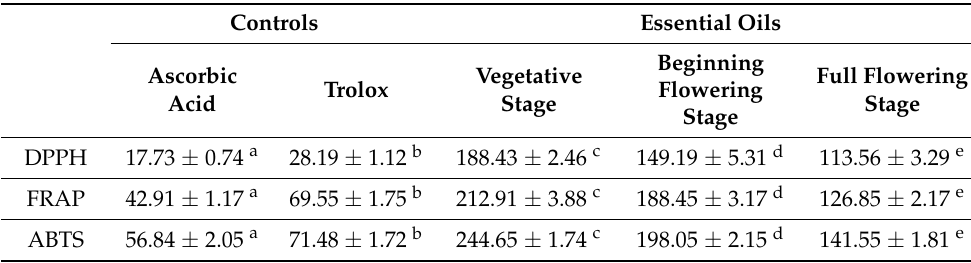
Table 3. The antioxidant activity of SOEO (IC 50 in µ g/mL) at three developmental stages. The results are presented as means ± SD (standard deviations) for triplicate assays. Controls Essential Oils Beginning Ascorbic Vegetative Full Flowering Trolox Flowering Acid Stage Stage